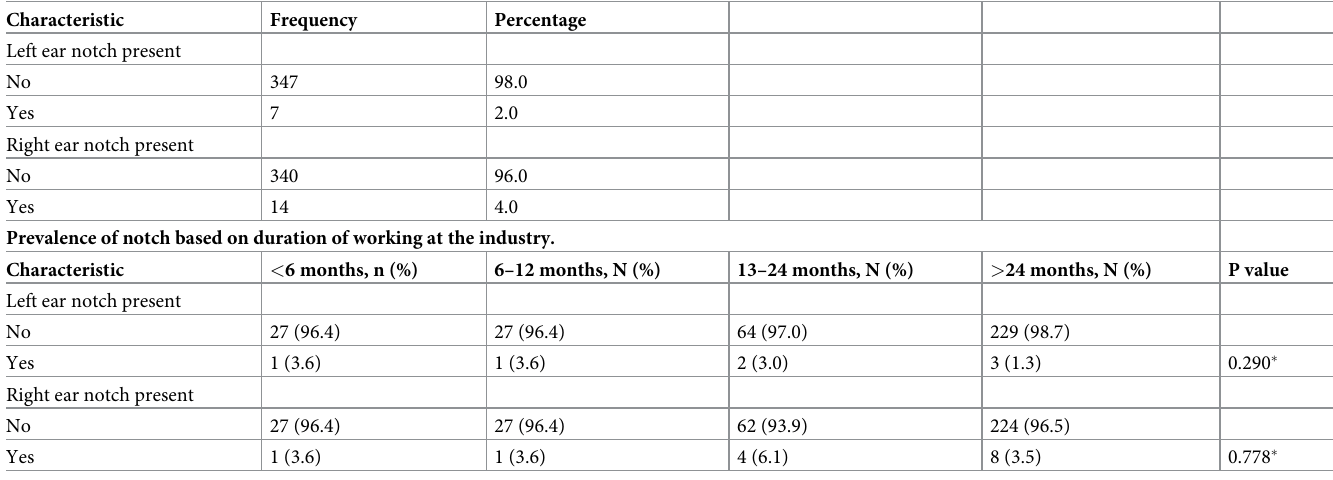
Table 4. Audiometric notch among the